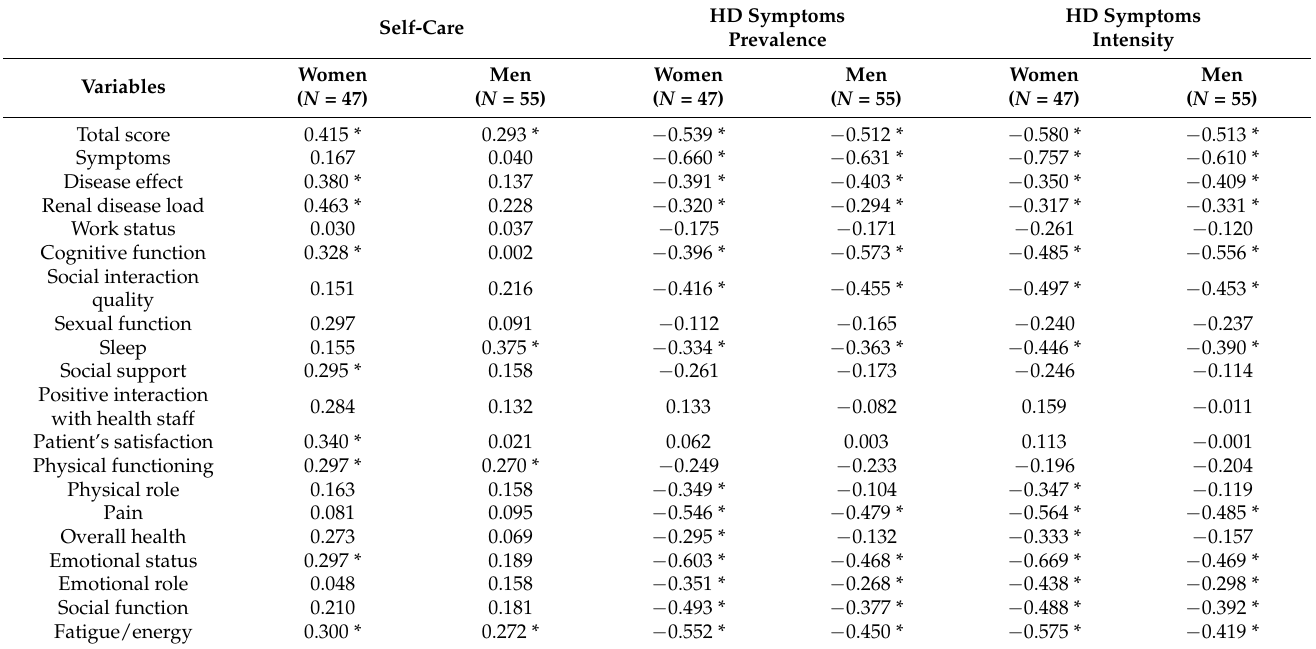
Table 4. Spearman correlation coefficients for quality of life (QoL), self-care, and HD symptoms in 102 KF patients. Significant correlations ( p < 0.05) are indicated with an asterisk